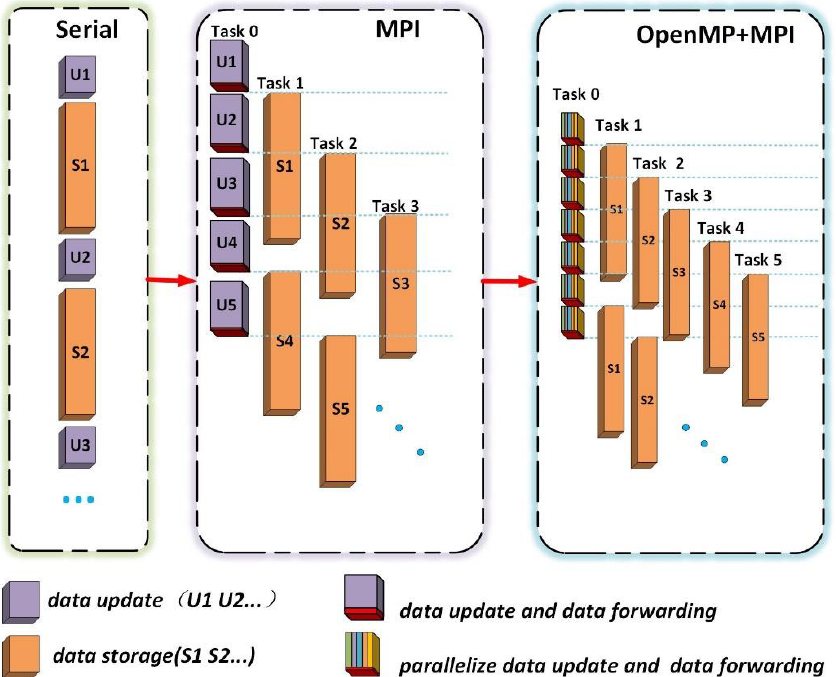
Figure 3. Parallel program